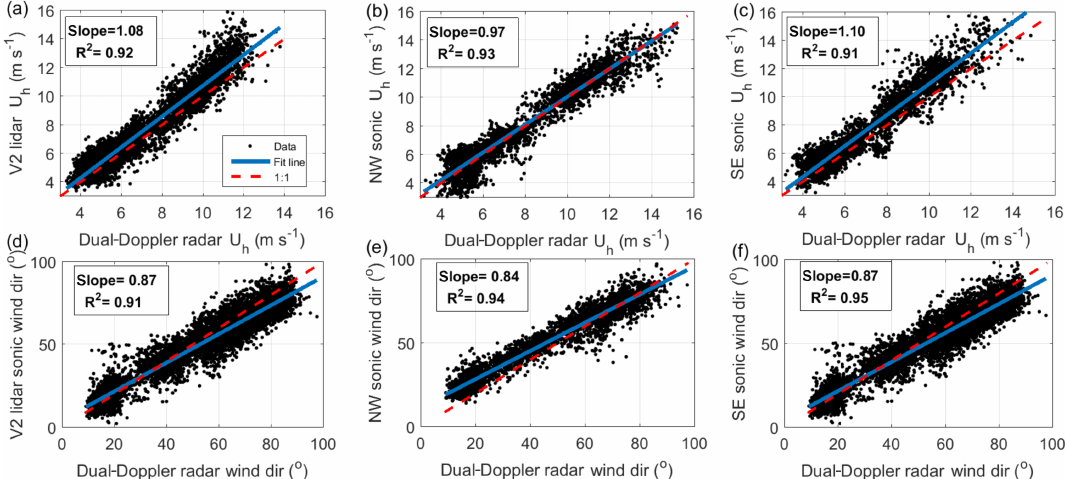
Figure 5. Linear regression analysis of the dual-Doppler radar retrieval against sonic anemometer and V2 lidar data for all the tested heights: (a–c) horizontal wind speed U h (ms − 1 ) ; (d–f) wind direction ( ◦